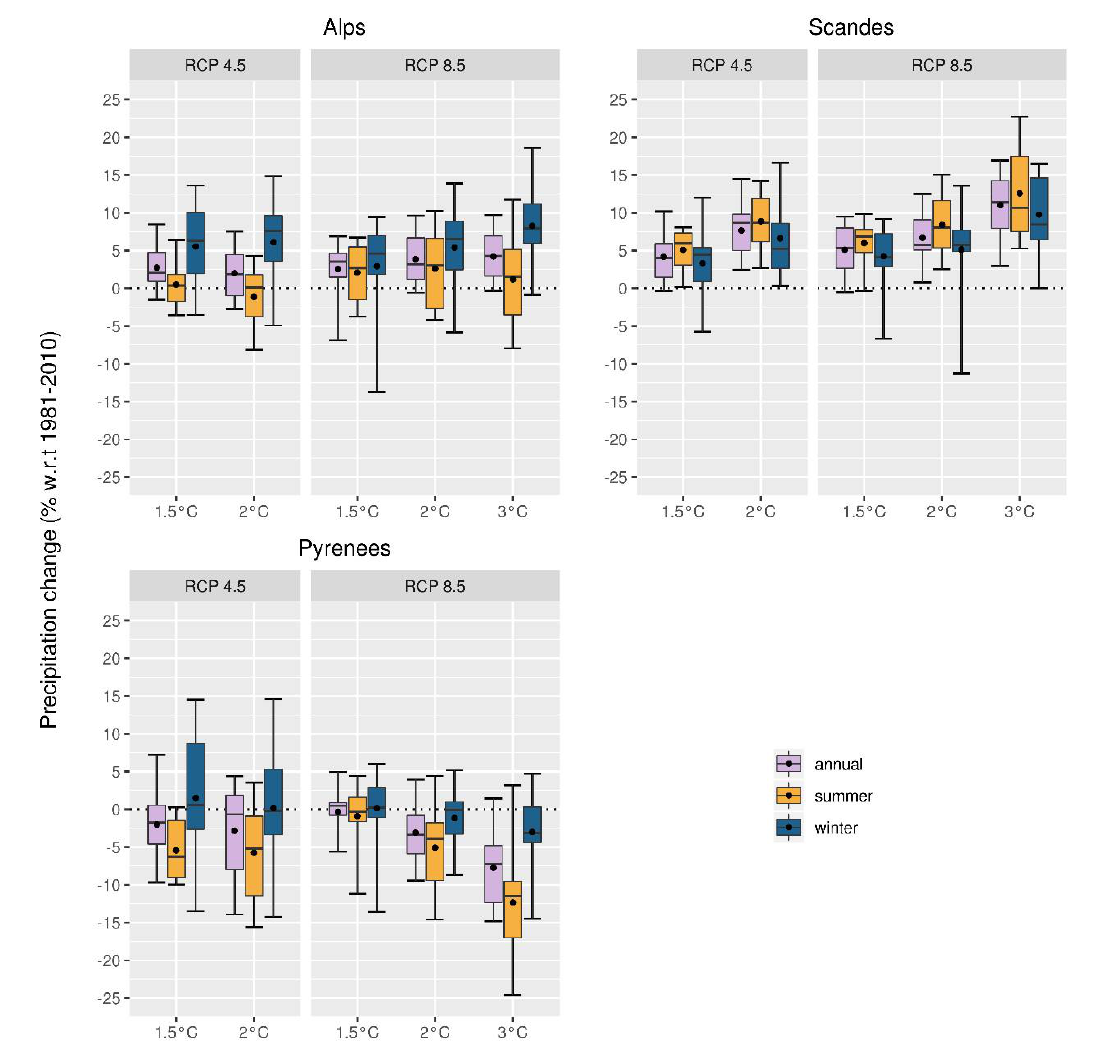
Figure A2. Projected precipitation change (%) in the alpine tundra domain (ATD) across scenarios relative to the reference period (1981–2010) in three regions. Results are shown for the 11 RCM simulations for RCP4.5 and RCP8.5 in in three warming levels. Summer (orange): precipitation of the summer half of the year; annual (purple): annual precipitation; winter (blue): precipitation of the winter half of the year. The median (horizontal line in boxes), mean (black circle in boxes), 25–75% range (boxes), and minimum to maximum range (whiskers) across the 11 simulations are shown for each scenario, period and season. Note that the 3 °C period was computed only under RCP8.5. Table A1. Projected mean annual temperature in the alpine tundra domain (ATD) across warming levels in three regions. Reference period (1981–2010) computed using CHELSA data [39]. Warming levels show the mean of the 11 RCM simulations for RCP4.5 and